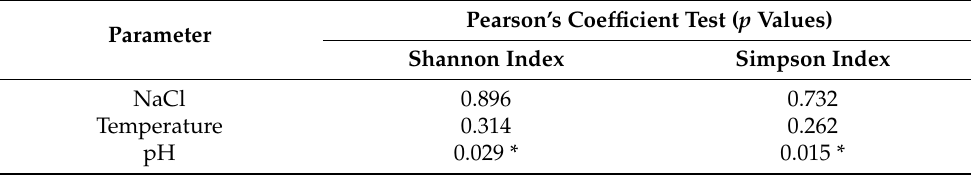
Table 2. Correlation between water physicochemical parameters and fungal diversity. The analysis was carried out using Pearson’s coefficient